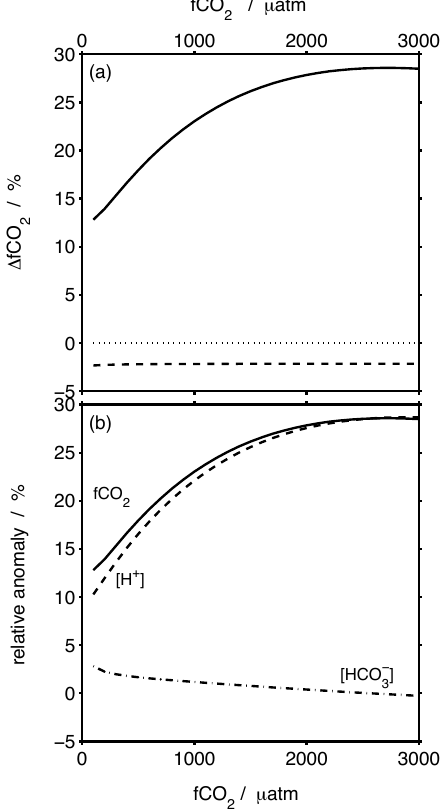
]. Colour code Fig. 4. Numerical simulations assuming a DOC-alkalinity of 3 50µmol kg − 1 (for details see Sect. 3.2). (a) 1f CO 2 (A ] computed as explained in Fig. 2. 3 line), 1f CO 2 (A (dashed line), and 1f CO 2 (C T , pH ) lines). (b) Relative anomalies (%) of f CO 2 , [H + ], [HCO −